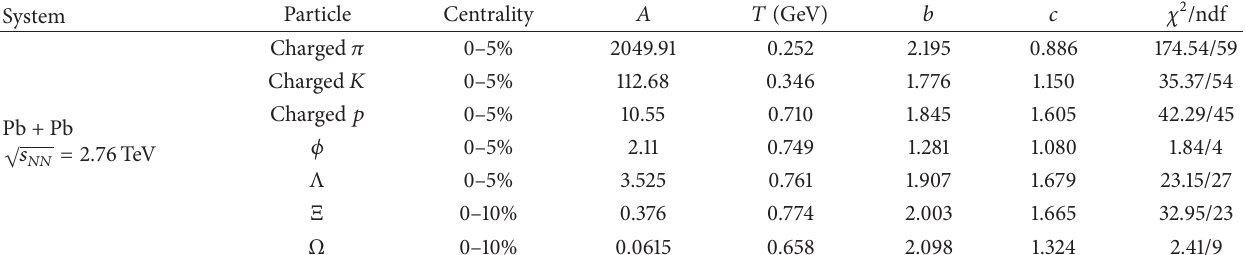
Table 2: The fitting parameters and the corresponding 𝜒 2 /ndf for different particles in Pb + Pb at √𝑠 𝑁𝑁 = 2 . 76 TeV with (12). System Particle Centrality 𝐴